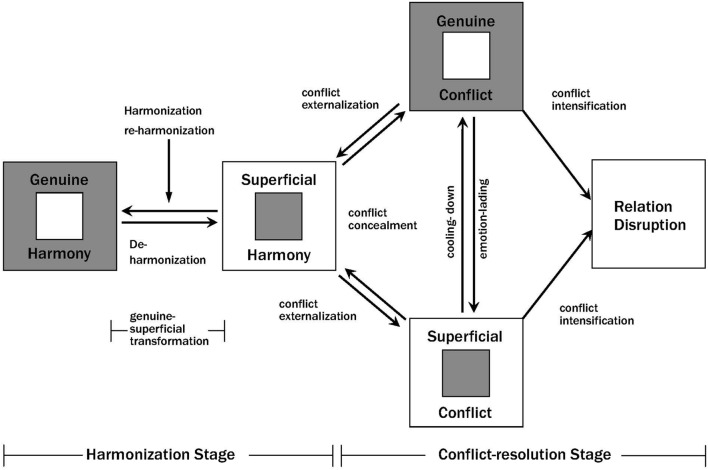
A dynamic model of interpersonal harmony and conflict (disharmony) (Huang, 1999, p. 136).